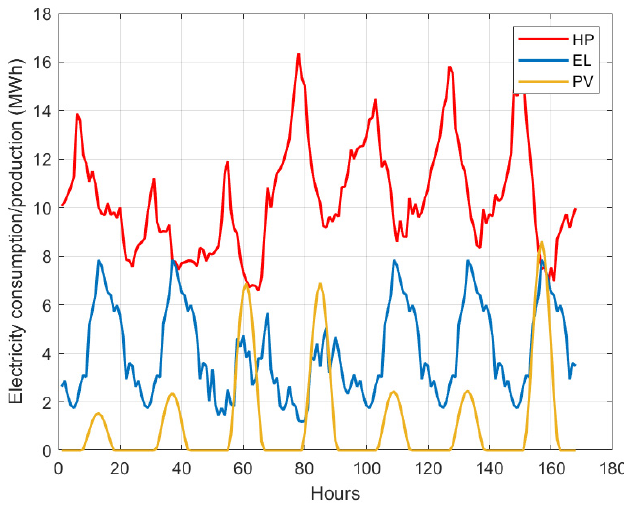
Figure 5. Simulated hourly power load profiles during a week of March.